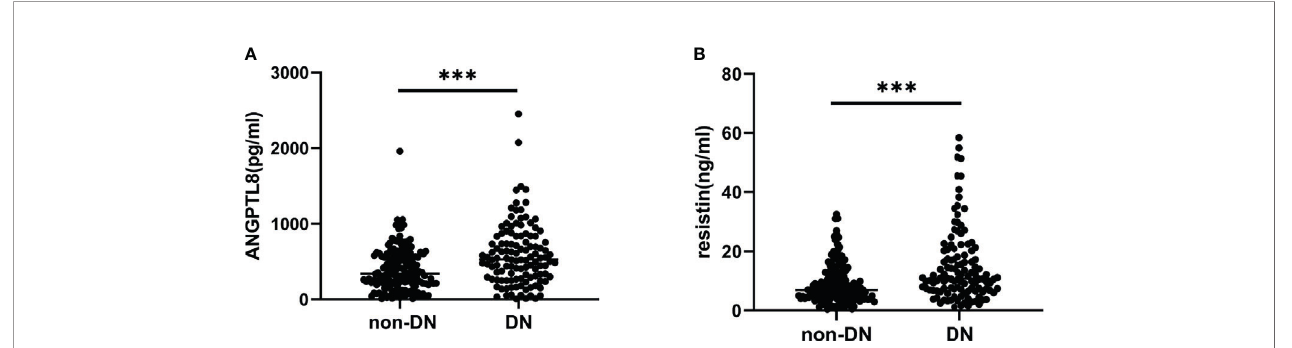
FIGURE 1 | ANGPTL8 and resistin levels in T2DM patients. (A) , ANGPTL8 levels were signi fi cantly elevated in the DN group. (B) , Resistin levels were higher in the DN group. ***p < 0.001 vs. non-DN group.